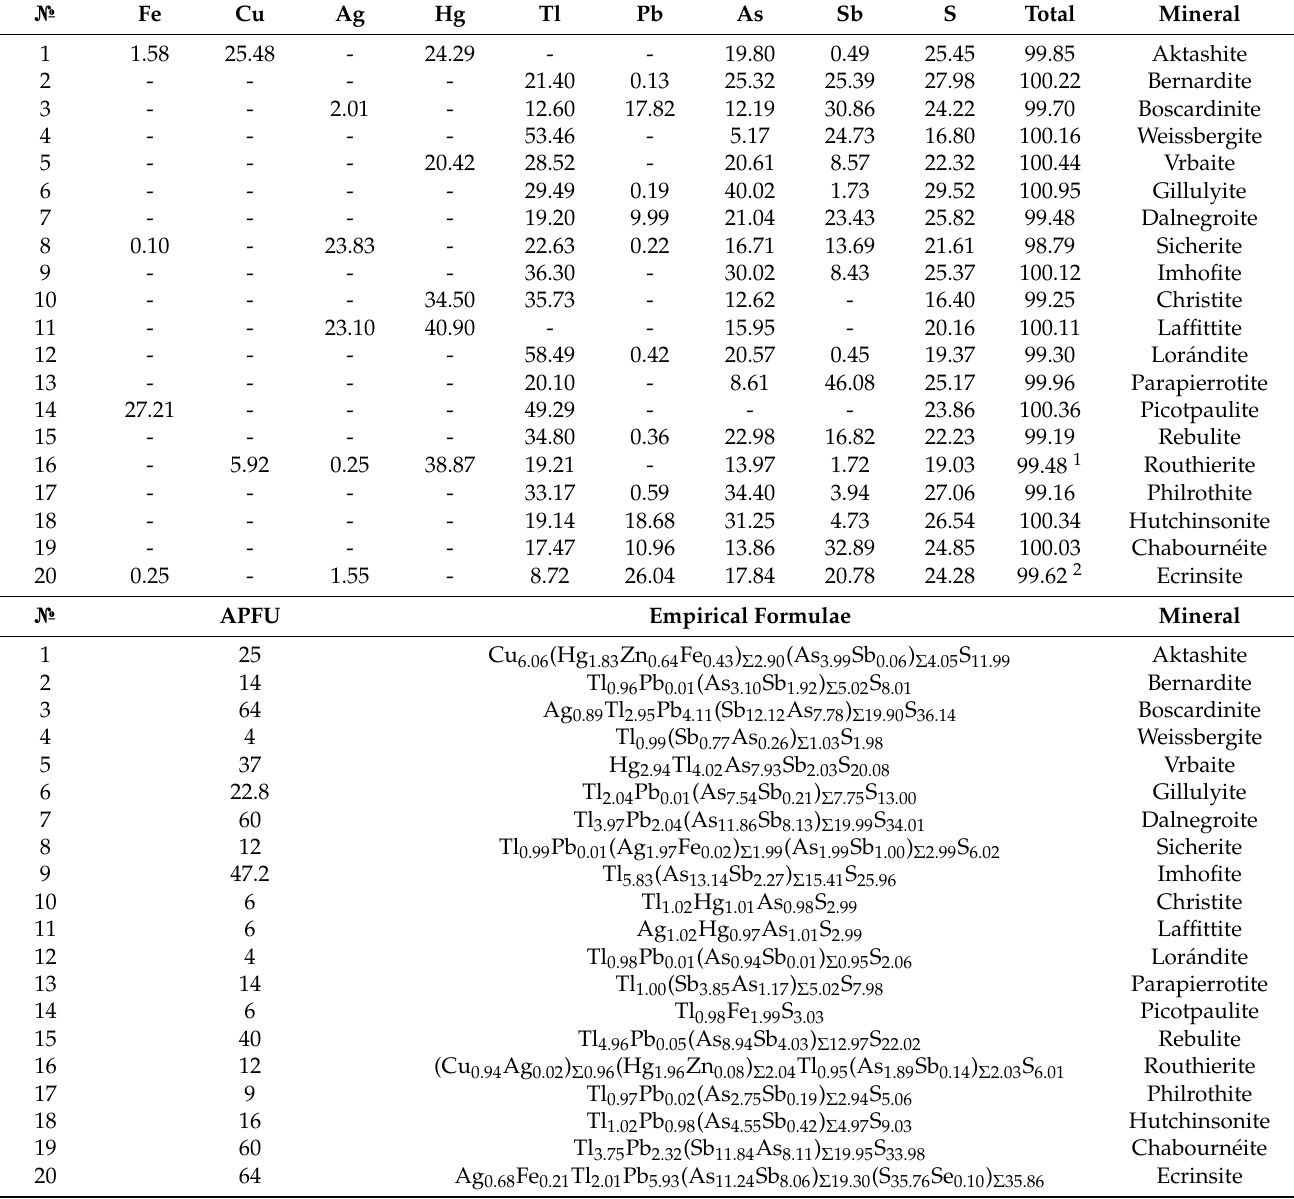
Table 1. The chemical compositions of Tl and Hg sulfosalts from the cement of gold ore breccias, wt.